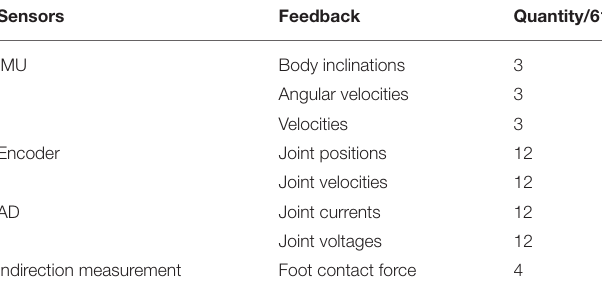
a detected inclination in the pitch or roll plane, the downward- TABLE 2 | All sensors and amount of sensory feedback of